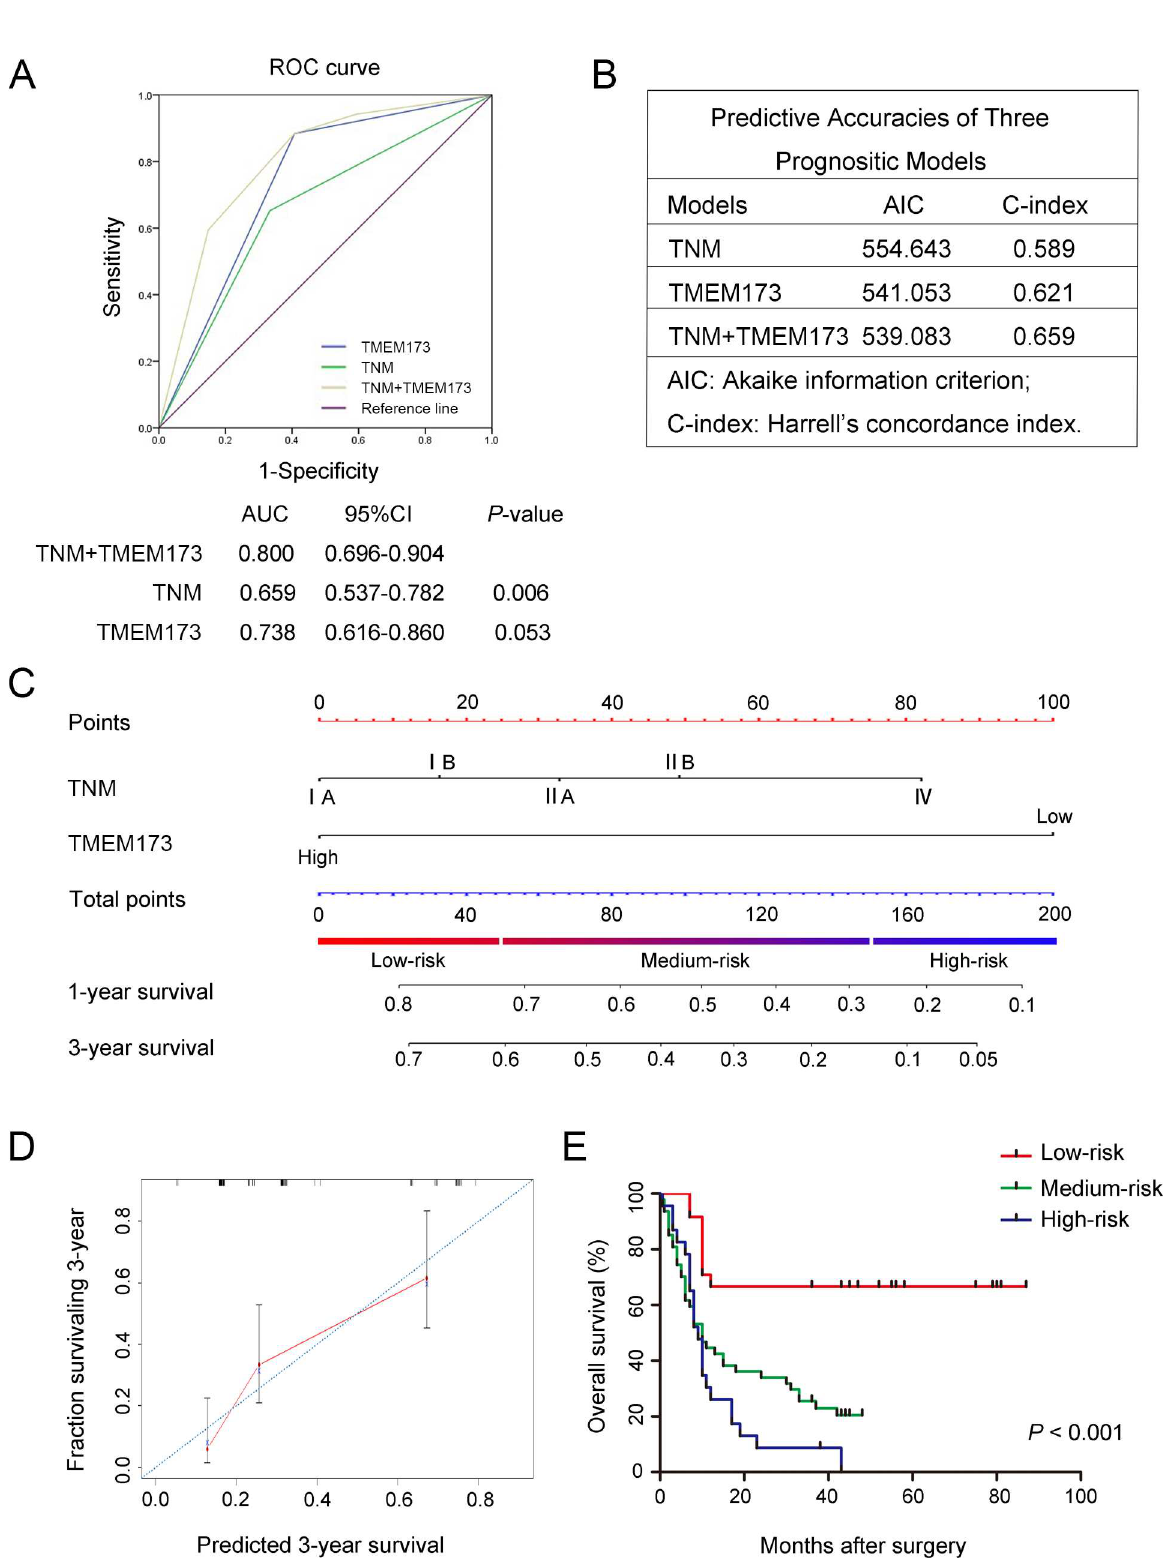
Fig 3. Combination of TMEM173 expression with TNM stage generates a better predictive model for overall survival of HCC patients. (A) ROC curve analysisof the sensitivity and specificity of the predictive value of the TNM stage model, TMEM173 model and the combinedmodel. (B) AIC and Harrell’s C-index analysis of the comparison of the predictive accuracies of TNM staging